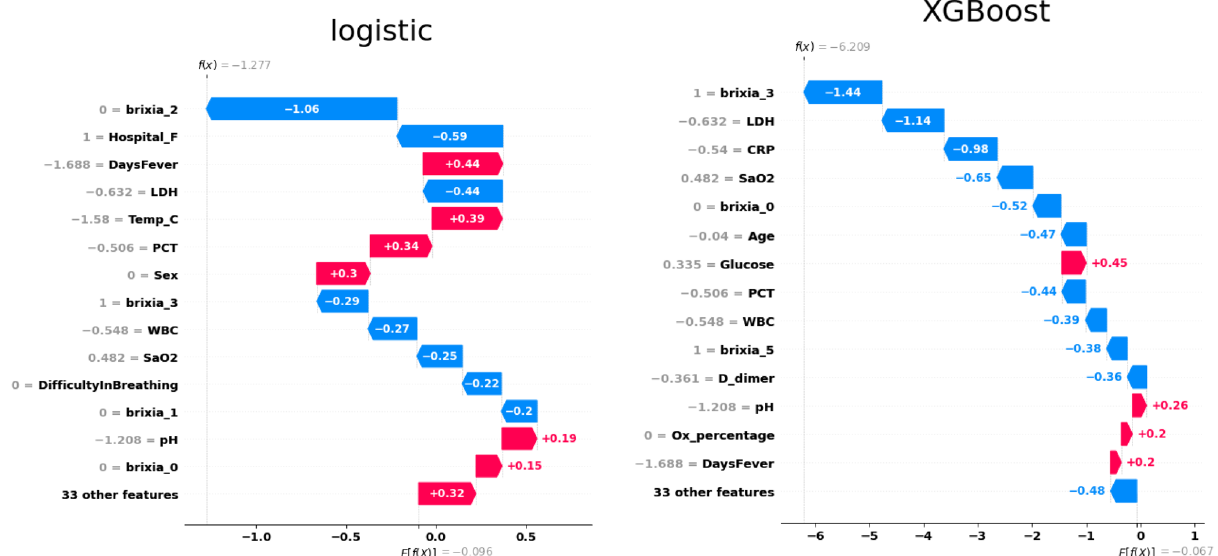
Figure 6. SHAP plots of the logistic (left) and XGBoost (right) models with the Brixia-scores; the expected model output is negative, therefore is biased towards the mild prognosis, we can see how relevant features contribute on average to either predicting a mild or a severe prognosis, from these plots we can see that the gender of a patient, the feverish days, pH levels, body temperature, age, being in a specific hospital, having a larger Brixia-score in a specific segment of the lung and some other factors influence the model towards a prediction of severe/mild